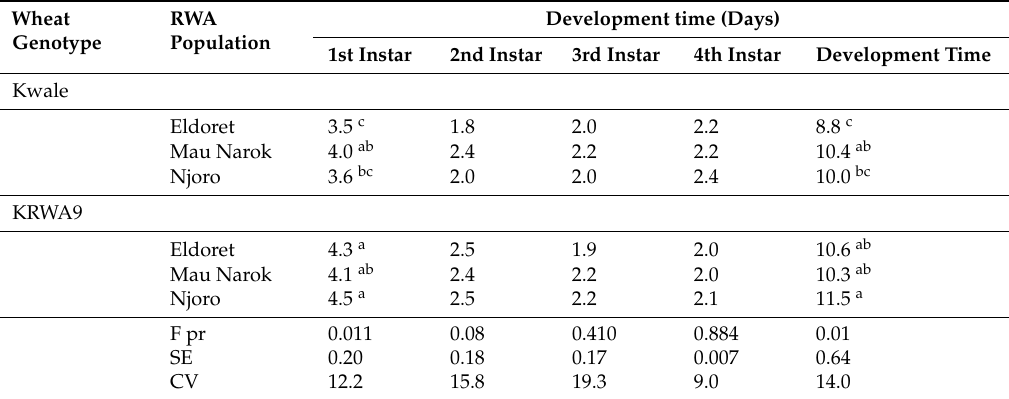
Table 5. The effect of wheat genotype on the reproduction time, total aphid lifespan, effective fecundity (M d ) and total fecundity of RWA. Variety